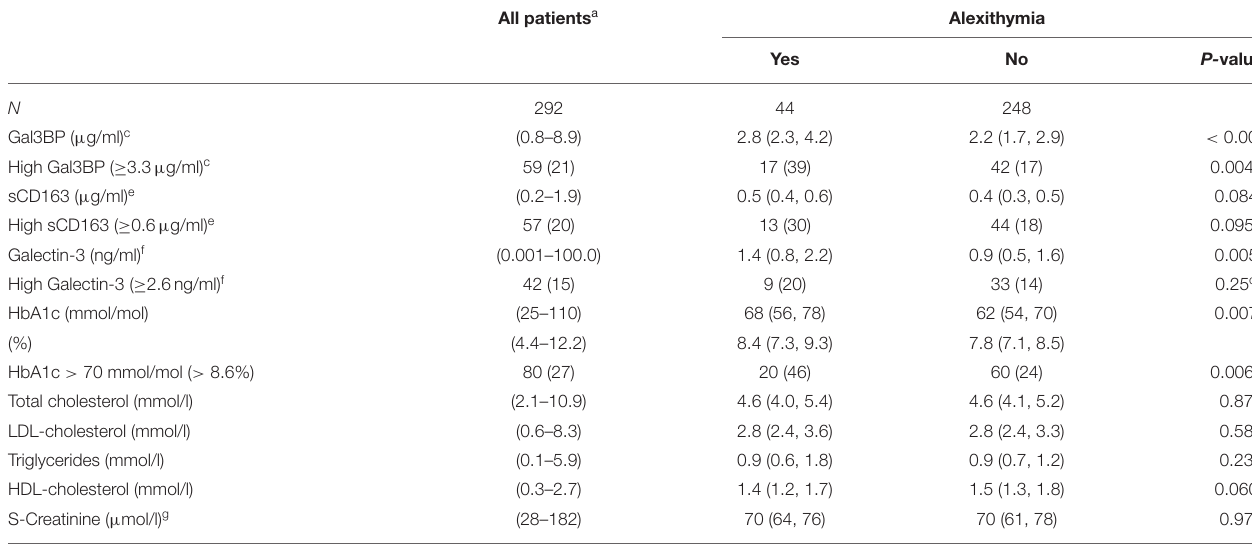
TABLE 2 | Results from biochemical analyses compared between 44 T1D patients with and 248 T1D patients without alexithymia. All patients